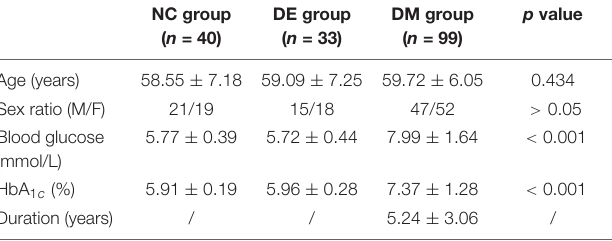
TABLE 1 | Demography of the subjects.